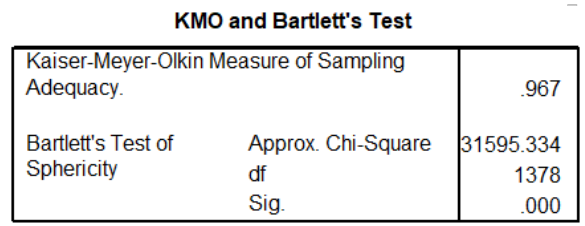
Fig. 1 The result of KMO and Bartlett test.